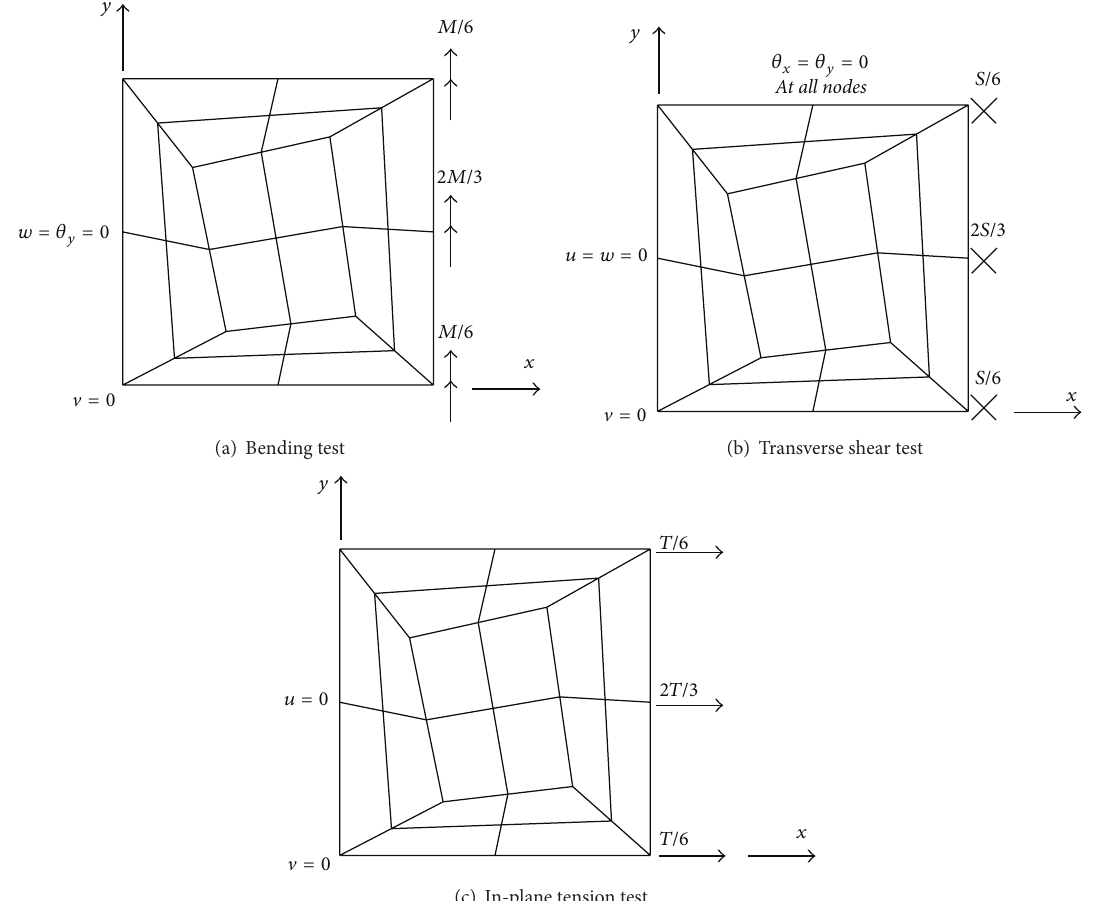
Figure 3: Mesh for patch test (Simo et al. [15]). Length of the square 𝐿 = 10 ; Young’s modulus 𝐸 = 1.0 × 10 7 ; Poisson’s ratio ] = 0.3 ; and thickness ℎ = 1.0 and boundary displacement conditions for patch